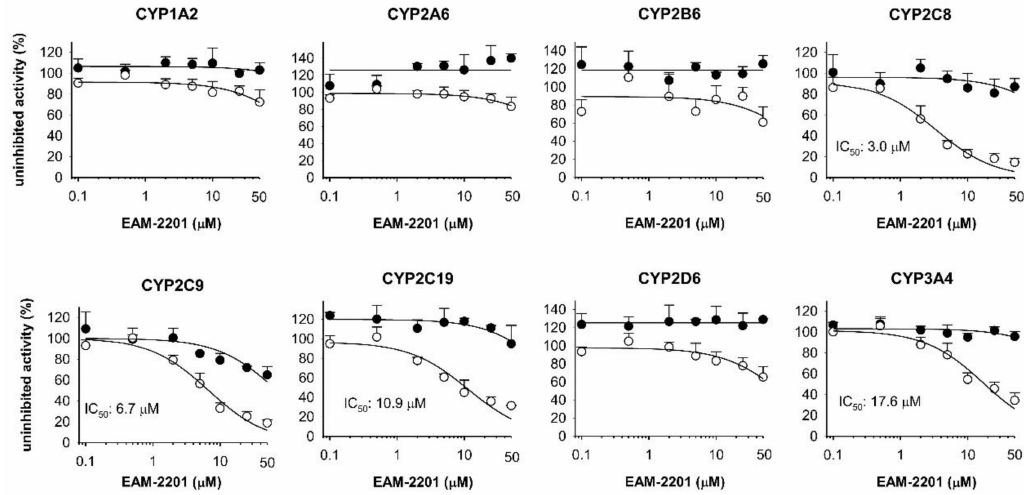
Figure 2. The inhibitory effects of EAM-2201 on CYP1A2-mediated phenacetin O -deethylase, CYP2A6- mediated coumarin 7-hydroxylase, CYP2B6-mediated bupropion hydroxylase, CYP2C8-catalyzed amodiaquine N -deethylase, CYP2C9-catalyzed diclofenac 4 (cid:48) -hydroxylase, CYP2C19-mediated